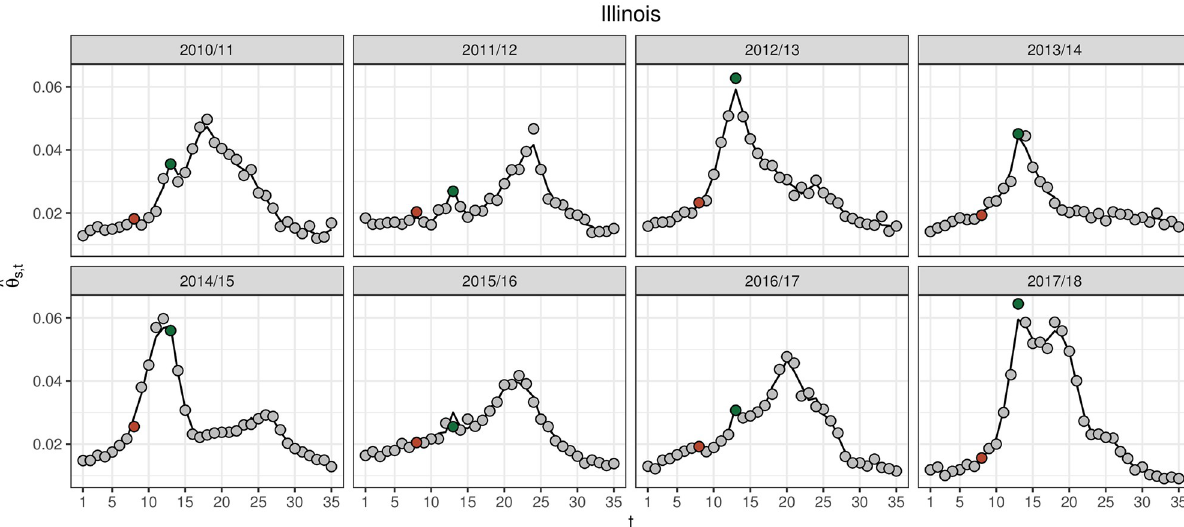
Fig 3. y (grey points) and ^ y (black line) for the historical seasons for Illinois. y for the week of Thanksgiving ( t = 8) and Christmas ( t = 13) are s , t s , t s ; t highlighted in brown and green, respectively. ^ y better matches y data on the holidays than ^ b (Fig 1) by accounting for the systematic reporting and s , t s ; t s ; t care-seeking changes over the holidays, as captured by ^ t t